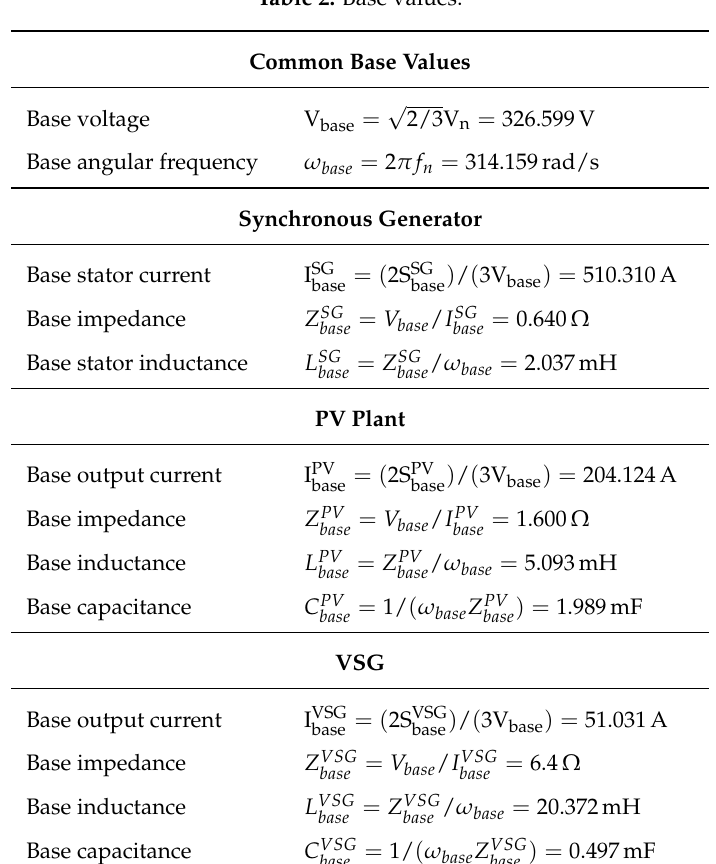
Figure 4. Block diagram of the microgrid under test. Table 2. Base